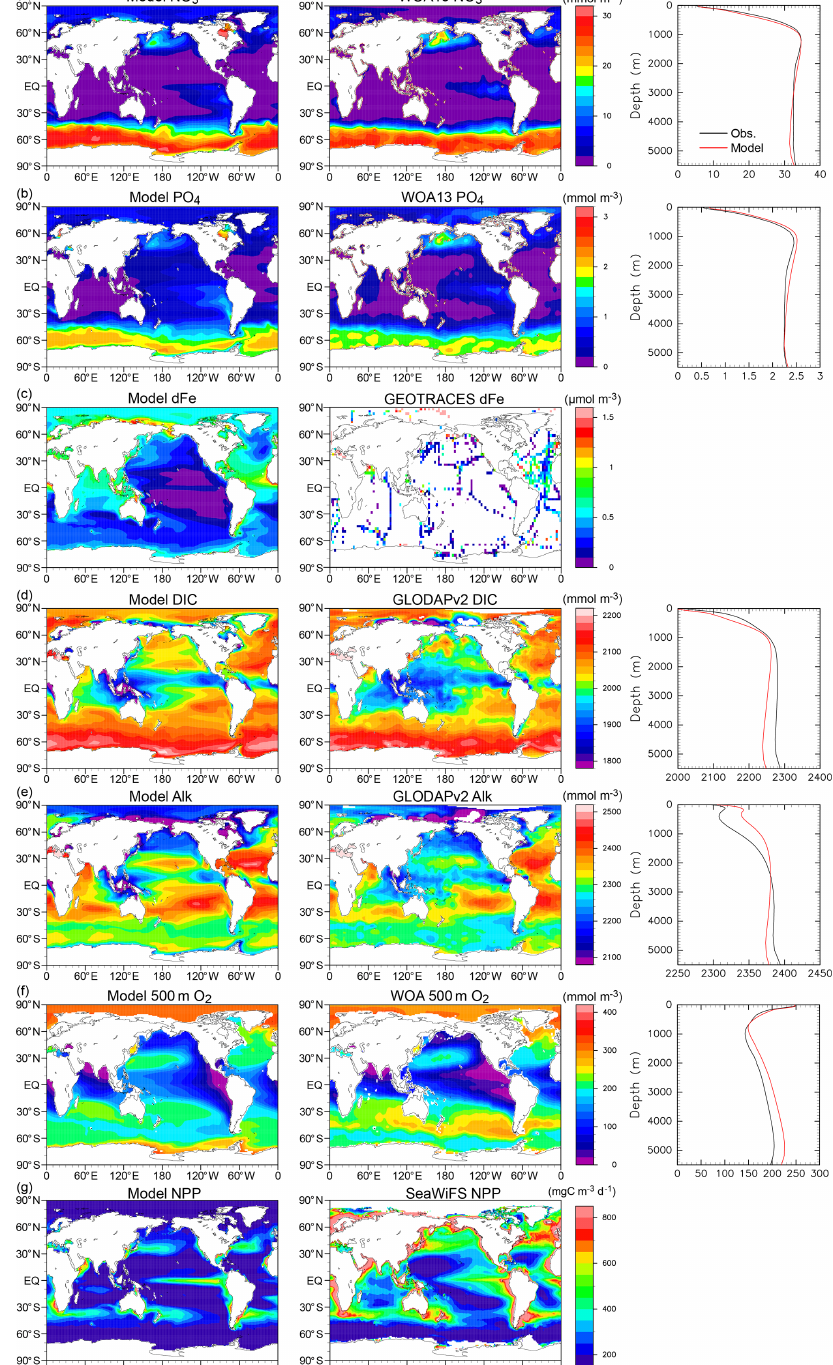
Figure 11. Comparison between model output and observations for key oceanic biogeochemical tracers. Simulated annual mean surface (a) nitrate, (b) phosphate, (c) DIC, (d) alkalinity, (e) dissolved oxygen at 500m of depth, and (f) surface NPP for the 2000s are compared with observations from the WOA2013 (Garcia et al., 2014a, b) and GLODAPv2 datasets (Lauvset et al., 2016), as well as SeaWiFS (Behrenfeld and Falkowski, 1997) satellite observations. Left and central panels show the horizontal distributions of model output and observations. Right panels show the vertical distributions of model output (red lines) and observations (black